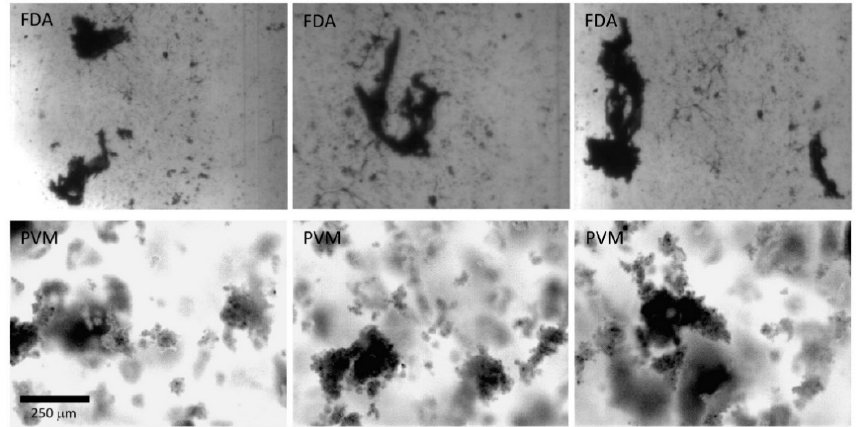
Figure 9. Comparison of FDA and PVM images for aggregates produced in the impeller mixer. Conditions: 30 wt % kaolin, 1000 g t − 1 Magnafloc ® 336. The PVM images were manipulated to enhance contrast and the color was inverted to simulate back-lighting conditions.